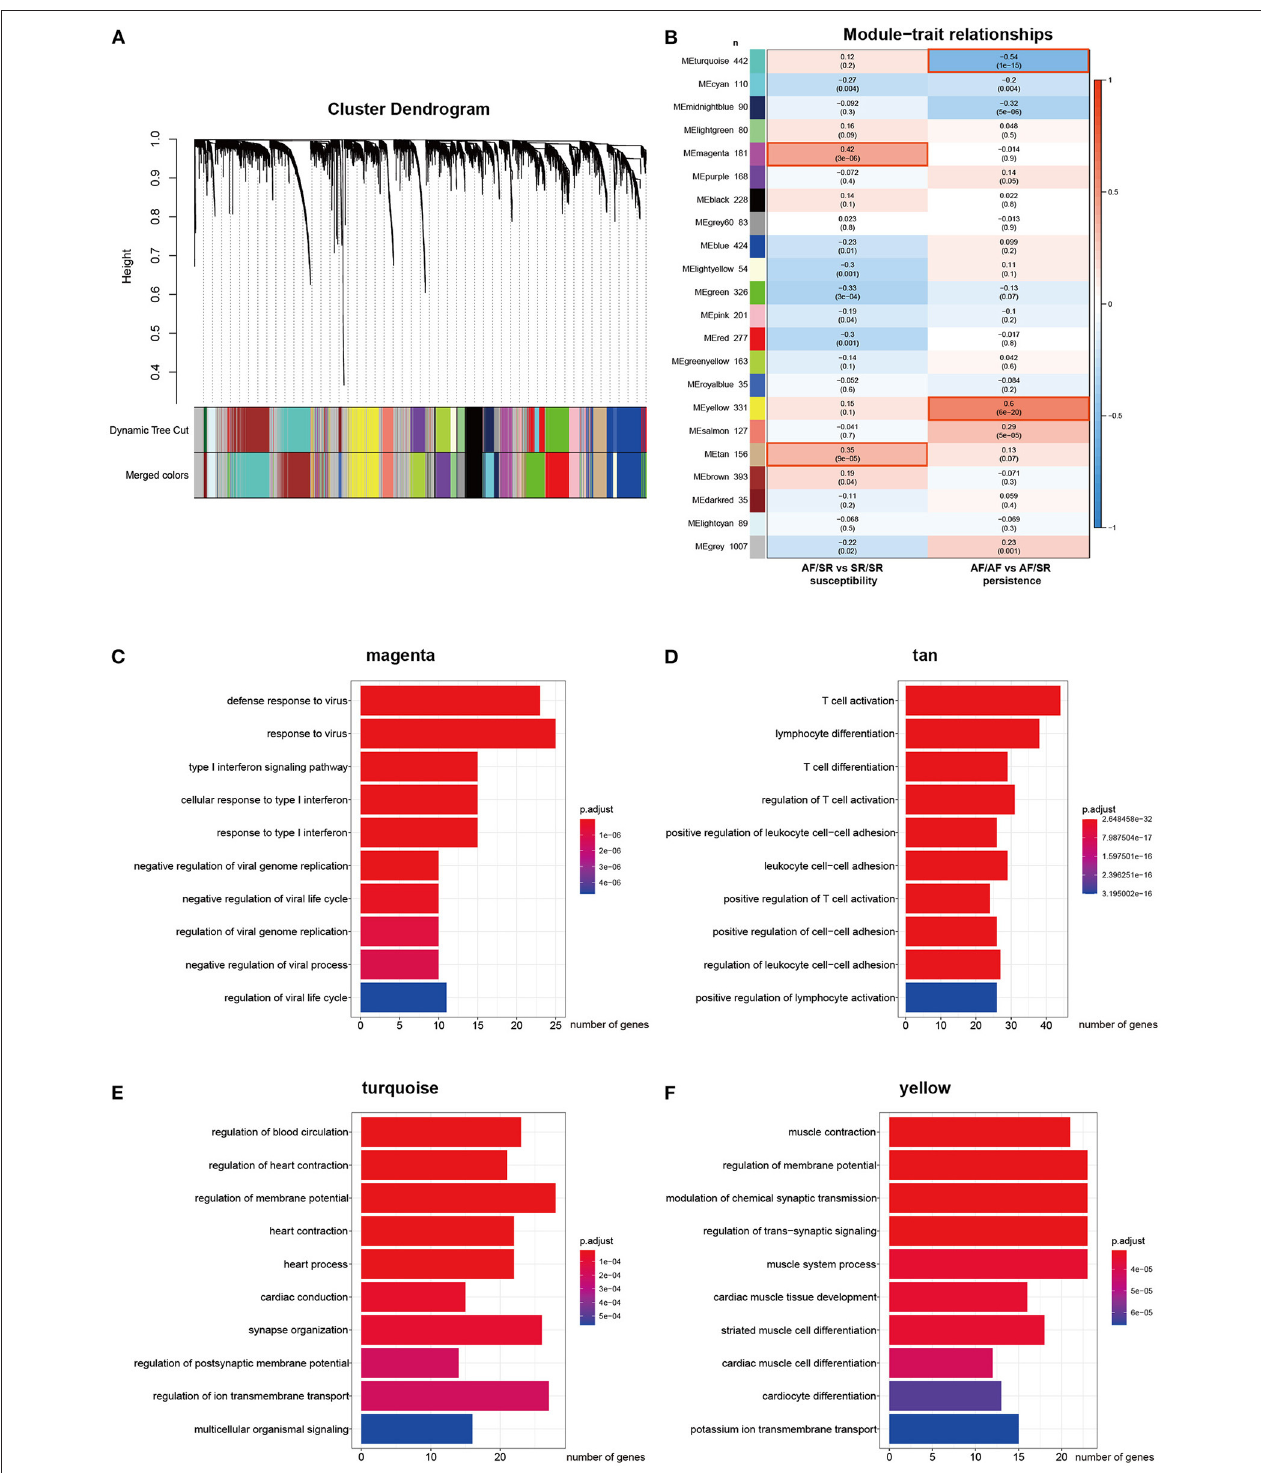
FIGURE 2 | Construction of the weighted co-expression network and module analysis. (A) Cluster dendrogram. The two colored rows below represent the original and merged modules. (B) Heat map of the correlation between AF susceptibility/persistence and module eigengenes. Each row corresponds to a different module eigengene, and each column corresponds to a different AF trait. Each cell contains the corresponding correlation (first line) and p -value (second line). (C–F) Top 10 enriched biological processes associated with the AF-related modules.